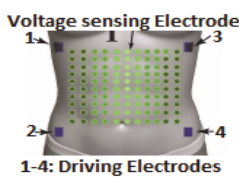
Fig. 7: Novel electrode configuration based on